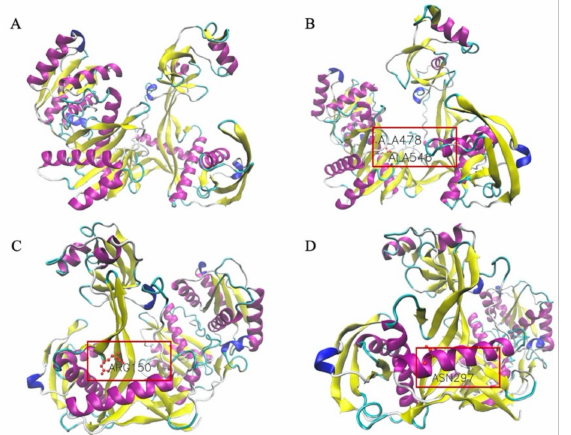
Figure 11. Structural simulation of TtAgo, TtAgoDM, TtAgo (G150R), and TtAgo (I297N). The figures were drawn in newcartoon method and colored by secondary structure, with alpha helix indicated in purple, beta-sheet in yellow, and amino acids colored in CPK (ball-and-stick model) style. ( A ) Structural simulation of TtAgo protein in apo form. ( B ) Structural simulation of TtAgo DM protein. ( C ) Structural simulation of TtAgo (G150R) protein. ( D ) Structural simulation of TtAgo (I297N)